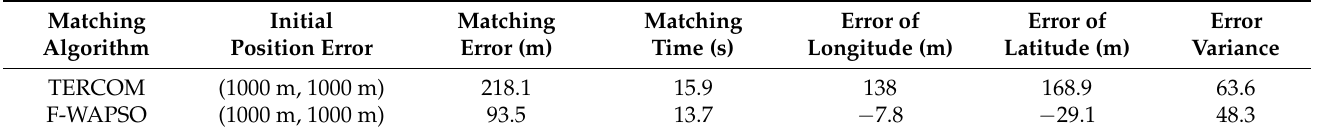
Table 4. Matching and error statistics of the two algorithms for trajectory B.